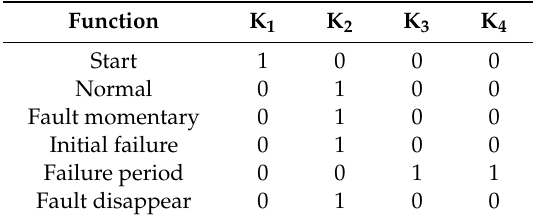
Table 1. Logic function of DC